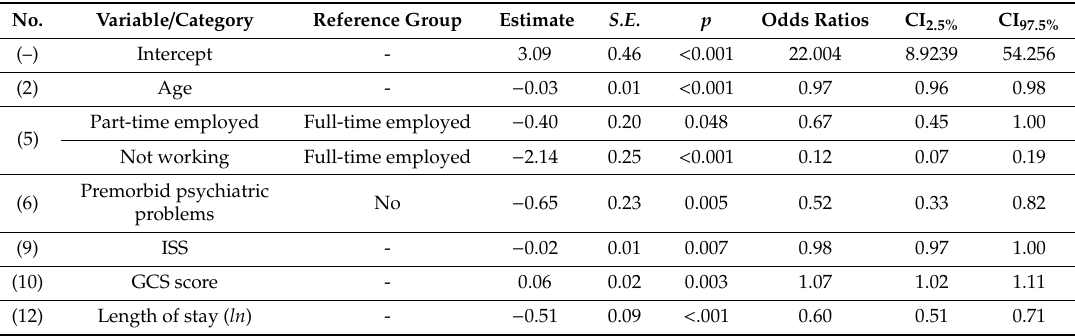
Figure 4. Odds ratios for the final model predicting probability of being employed one-year after TBI. Asterisks (*) indicate significant factors or factor levels. Values < 1 represent factors and factor levels with decreased probability of being employed one-year after TBI; values > 1 indicate for a higher probability of employment. Numbers in parentheses are referred to Table 1. The optimism-corrected Nagelkerke’s R² demonstrates the relative information gain of the final model compared to the null model (model without predictors, and intercept only). Table 2. Results of logistic regression analyses .